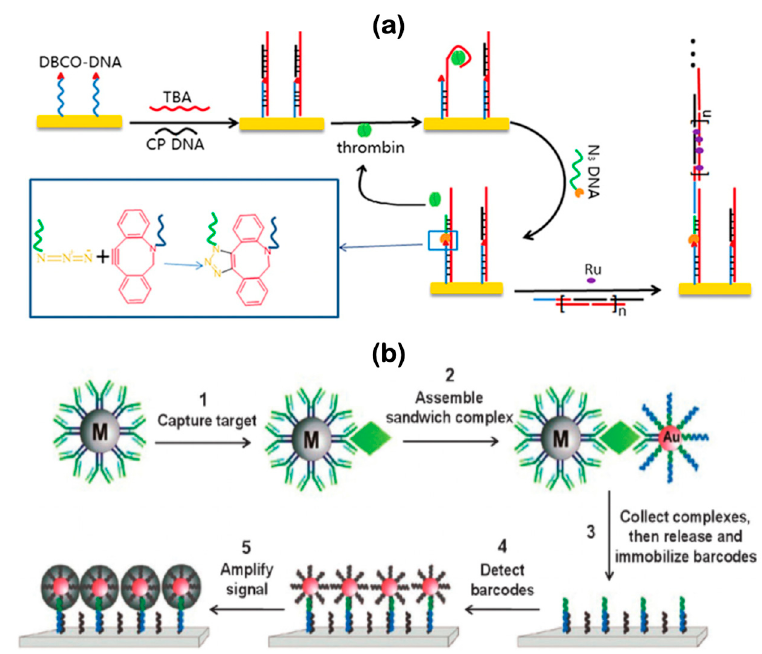
Figure 6. Applied DNA nanotechnology for the detection of nucleic acid and protein targets without PCR: ( a ) An electrochemical biosensor based on dual amplification to detect targeted thrombin as low as 30 fM; ( b ) A barcode microarray biosensor based on a combination of NPs and sequence-specific DNA with multiplexing different targeted molecules. Adopted with permission from [151].